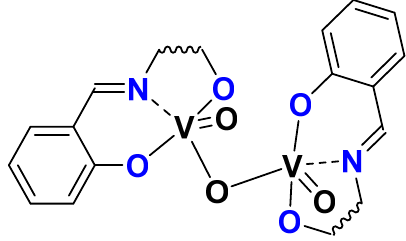
Figure 19. Schematic representation of [VO(L)] 2 O complexes (L = SAP, SAE,